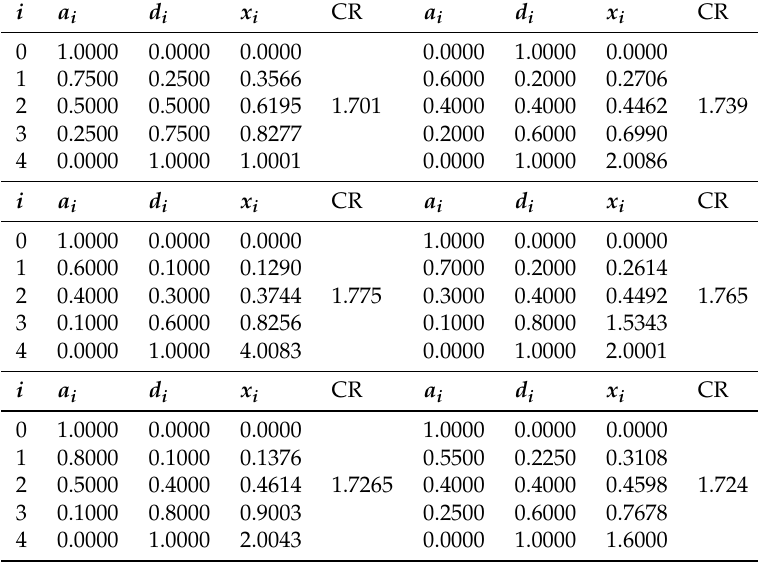
Table 5. Simulations results for various five-state systems (given by a i and d i parameter values) when θ = 0.01. Competitive ratios are well below